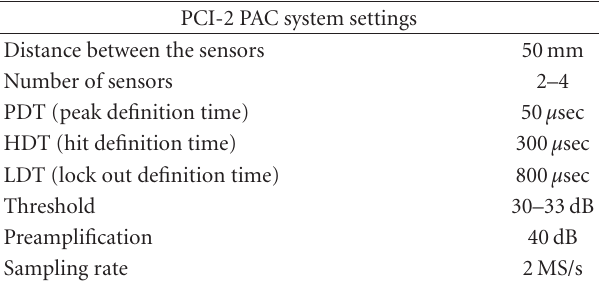
Table 3: Acoustic emission system